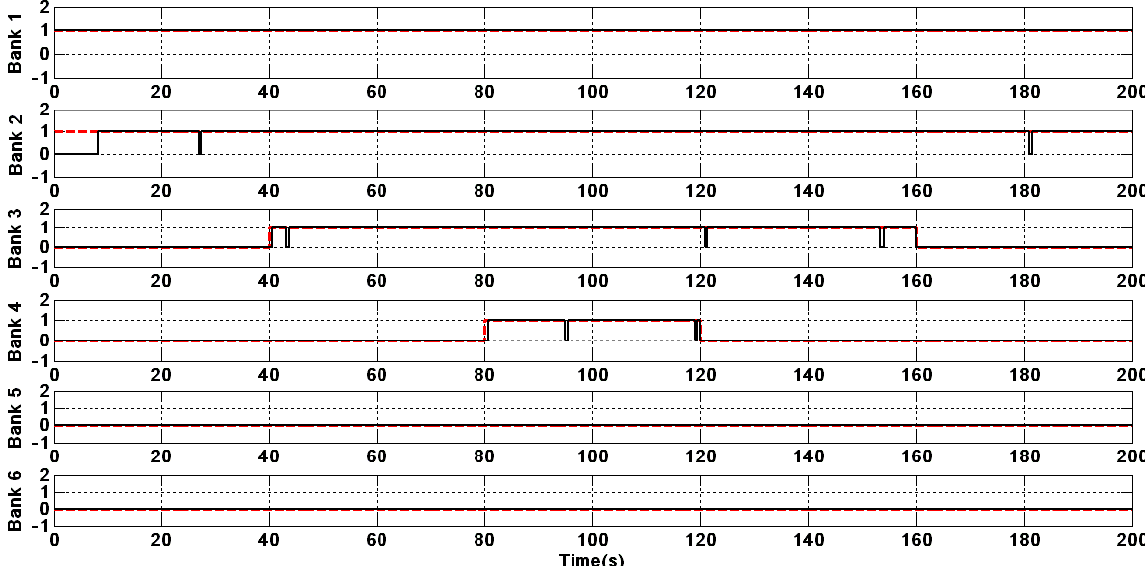
Figure 10. Automatic switching of the banks for the power reference of four banks (modified PI pitch angle